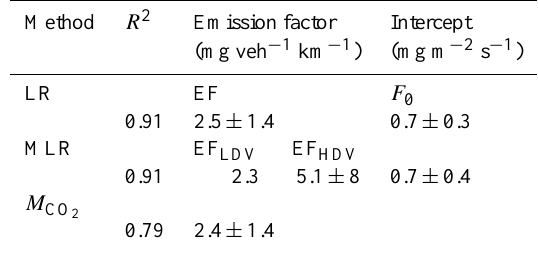
Table A2. Comparison between the different attempts to find a source parameterization ( F ) for refractory aerosol particles smaller than 0.6µm D p . The traffic activity used is the mean daily traffic activity from (Monday–Friday, 24 values) in the NE sector over an area of 1km × 1km, (TA, traffic activity, light duty vehicles (LDV) and heavy-duty vehicles(HDV)). The fol- lowing abbreviations are used (LR: linear regression (Equation F =EF Fleet mix TA+ F 0 ); MLR: multiple linear regression (Equa- tion F =EF LDV TA LDV +EF HDV TA HDV + F 0 )); M CO : EF based 2